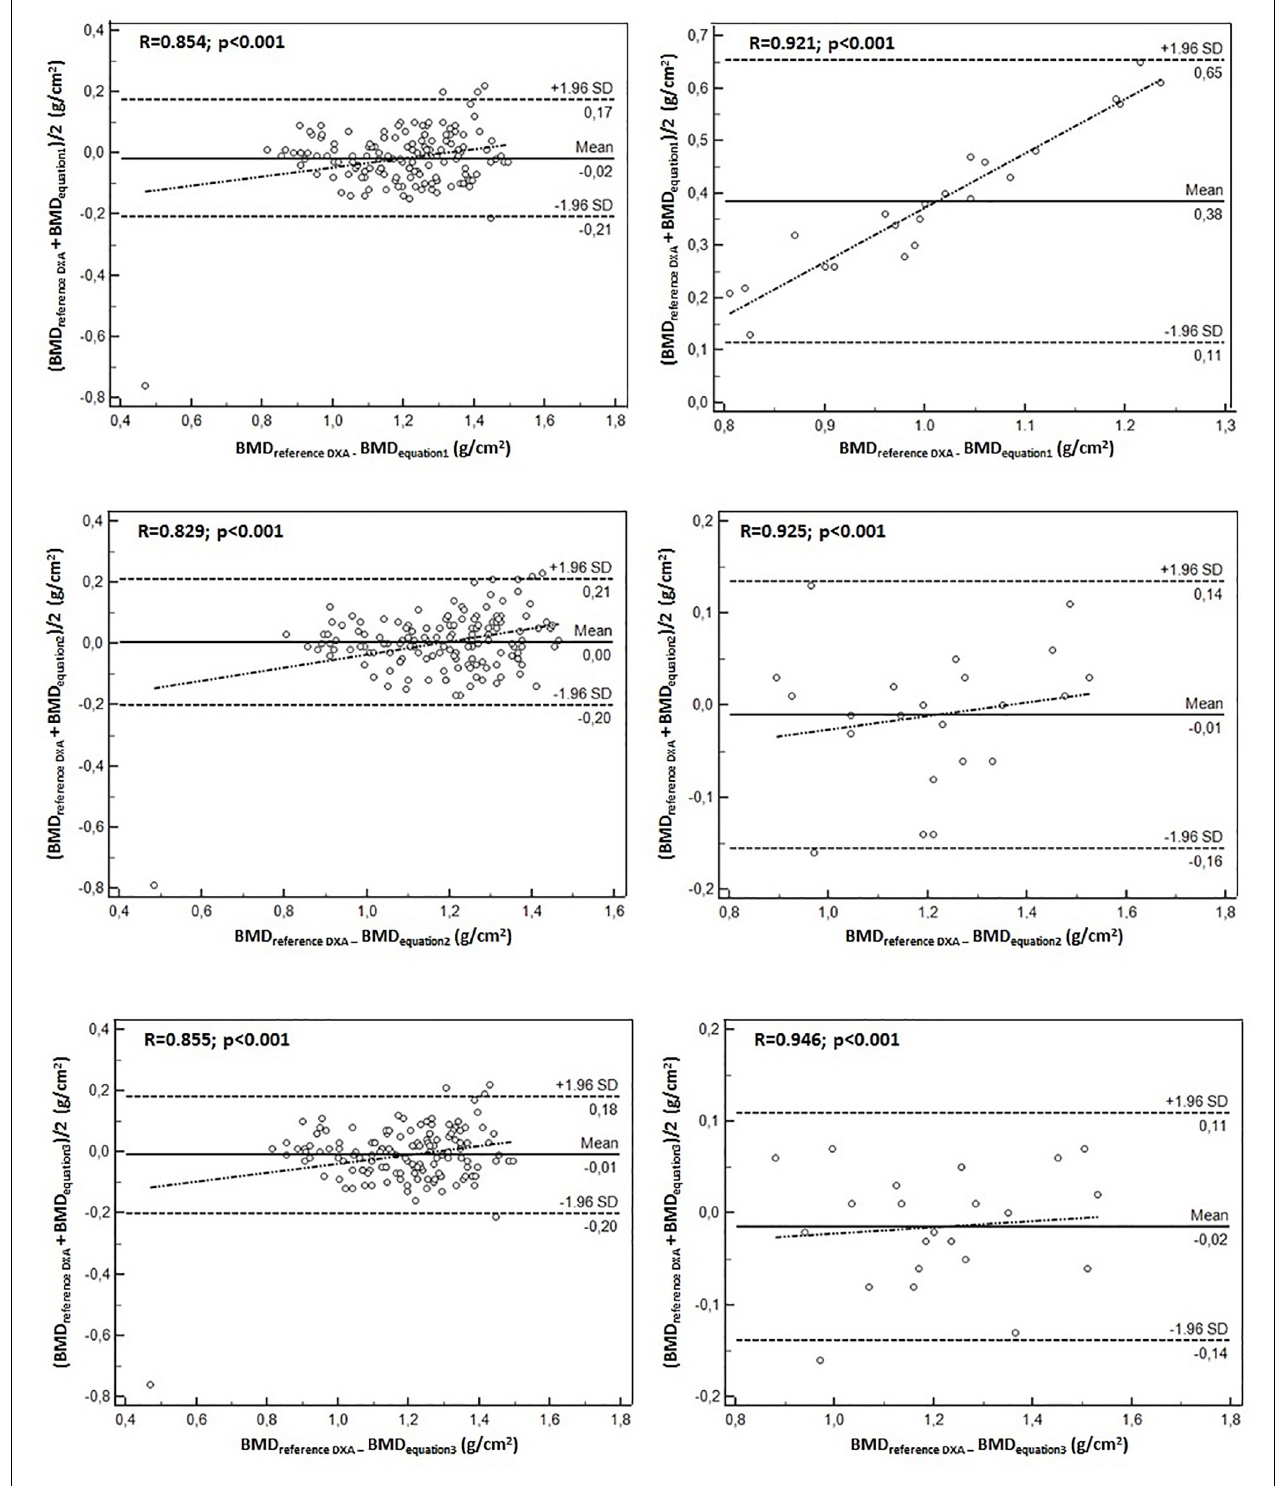
FIGURE 2 | Bland–Altman plot for the correlation between the BMD values determined by the reference method (DXA) and the three predictive equations for goalkeepers (left) and field players (right).